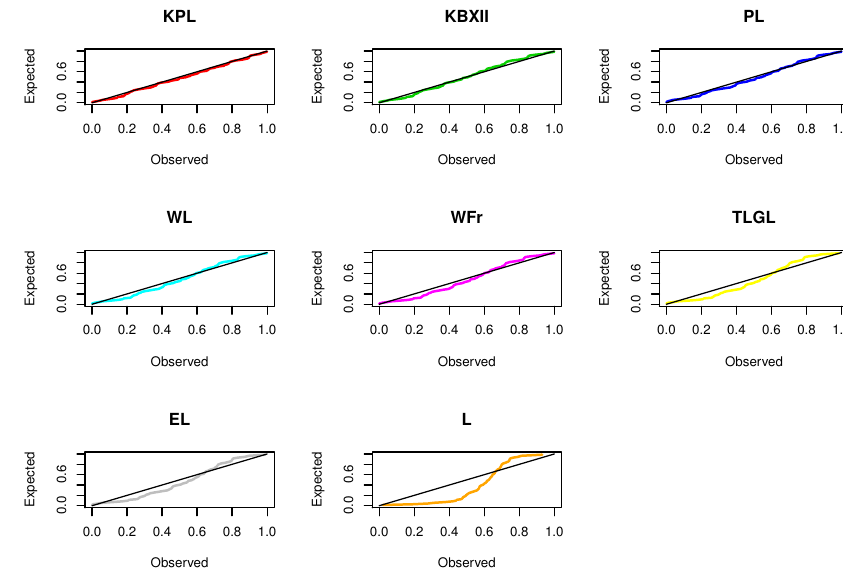
Figure 4. Fitted PP plots of the distributions for data set